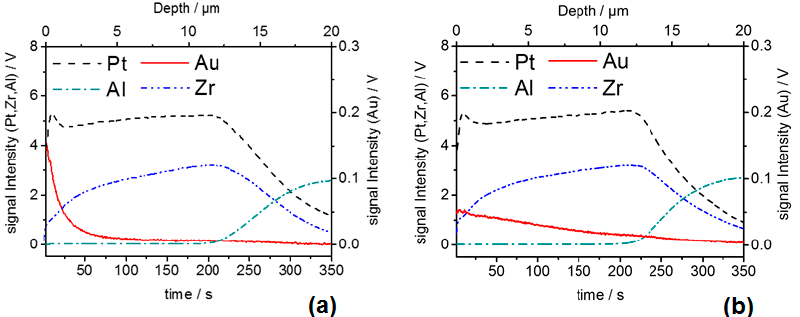
Figure 3. ( a ) GD-OES analysis of elemental depth profile of the self-prepared model sample sintered at 850 °C for 10 min; ( b ) elemental depth profile of the model sample sintered at 1050 °C for 4